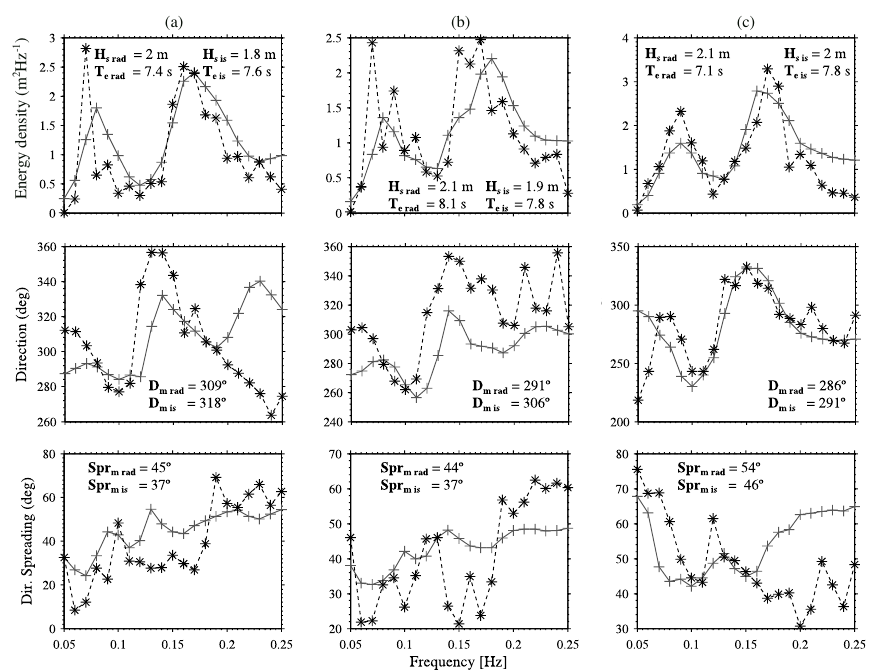
Figure 7. As in Figure 5, but for 24 September 2012 at 1100 UTC.